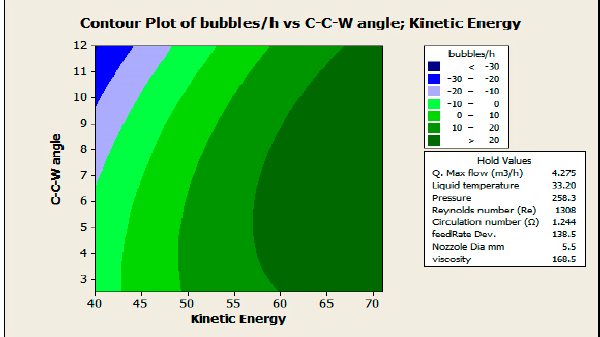
Figure 11. The contour plot of bubbles/h under feed rate and viscosity intersection.